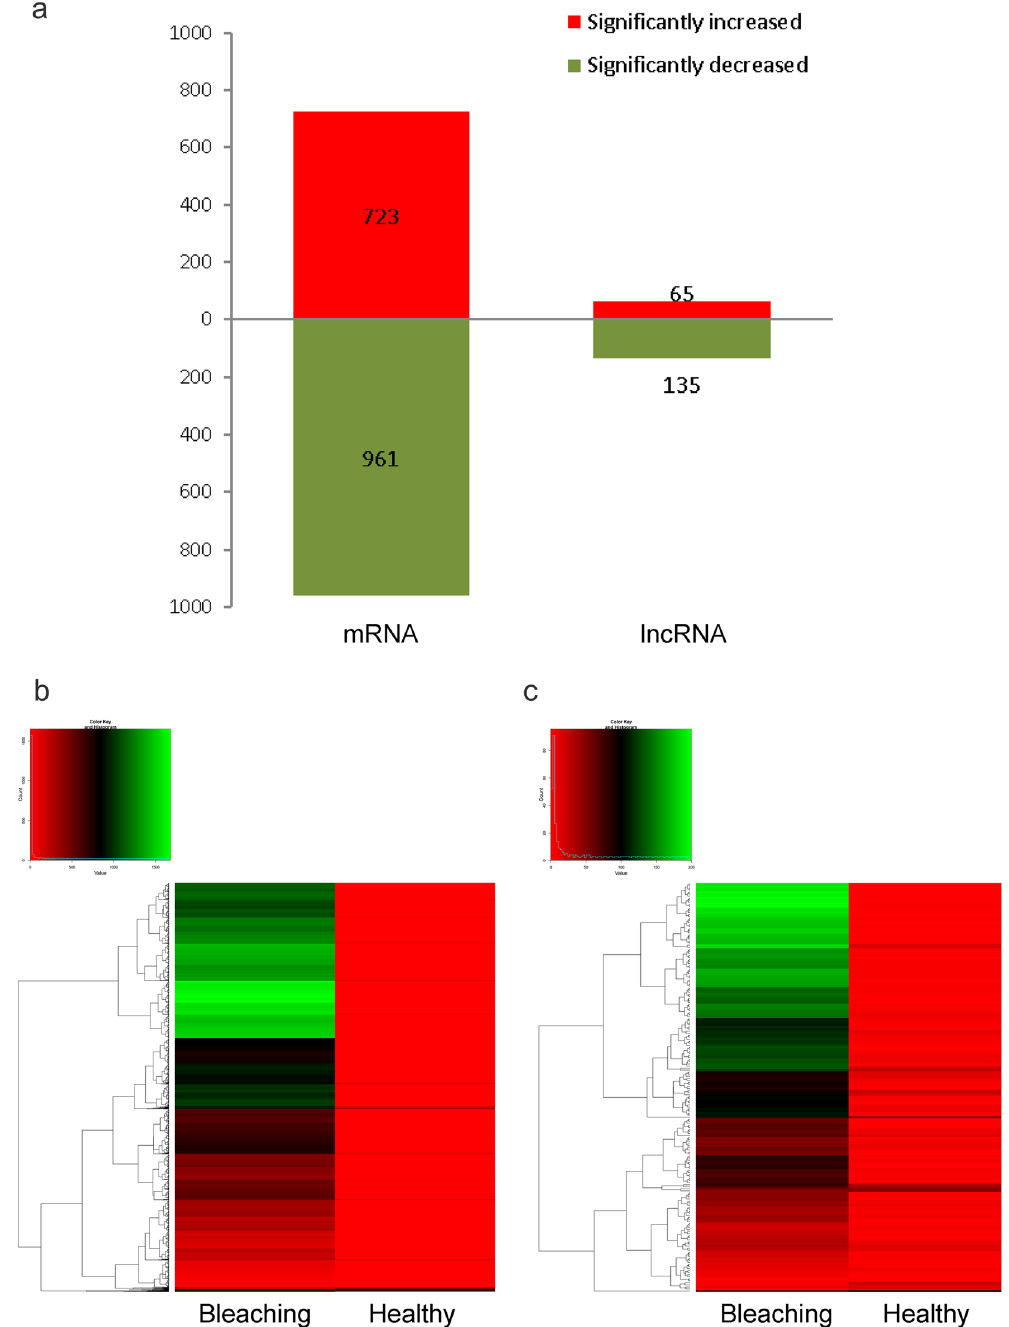
Figure 7. Comparison of differentially expressed mRNAs and lncRNAs identified in healthy P . caribaeorum and in colonial individuals undergoing bleaching. ( a ) Histogram plot of significantly differentially regulated mRNAs and lncRNAs in P . caribaeorum tissue undergoing bleaching compared to healthy tissue. ( b , c ) Hierarchical clustering and scatter plot of overall mRNAs ( b ) and lncRNAs ( c ) differentially expressed in P . caribaeorum tissue undergoing bleaching compared to healthy tissue. Red: lower expression levels, green: higher expression